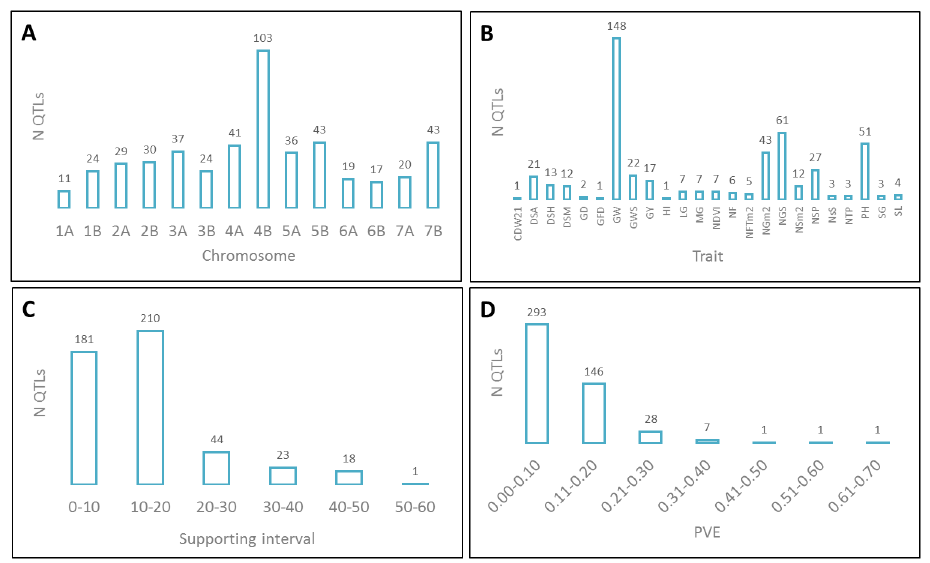
Fig 3. Parameters estimatedin QTL studies collected for meta-analysis. Number of QTLs per A) chromosome, B) trait, C) supporting interval (cM) and D) phenotypic varianceexplained.